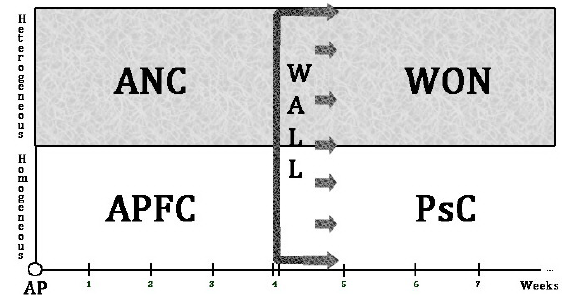
Figure 1. Differences between definitions on Atlanta 1992 and Chicago 2012. AFC: acute fluid collection; PN: pancre - atic necrosis; APC: acute pseudocyst; PAbs: pancreatic abscess; WON: walled-off necrosis; ANC: Acute necrotic collection; APFC: acute peripancreatic fluid collection